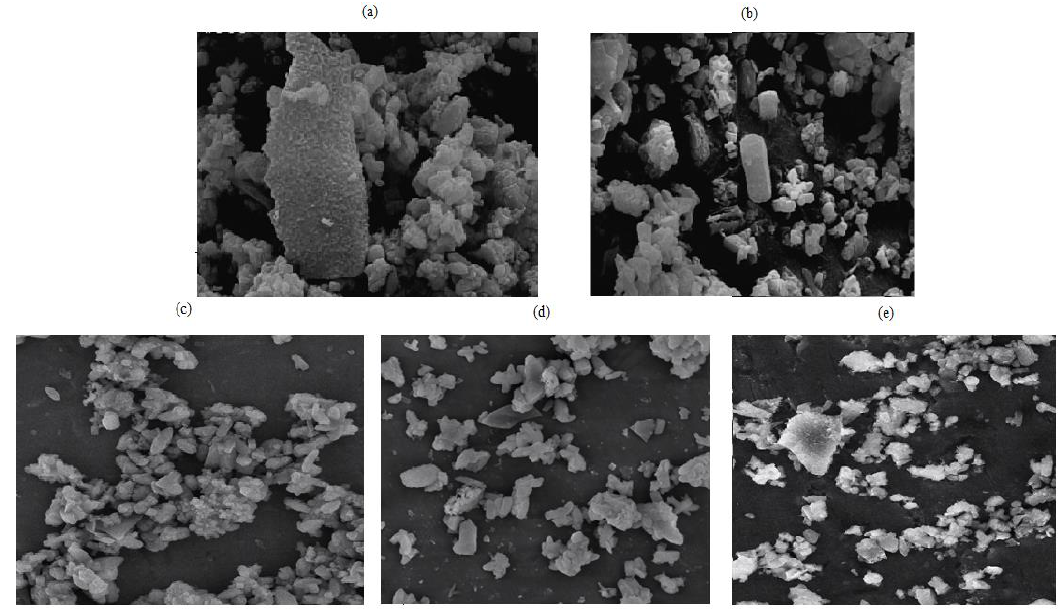
Figure 2. SEM images for ( a ) NaZSM-5; ( b ) HZSM-5; ( c ) 4 wt. % FeHZSM-5; ( d ) 4 wt. % CuHZSM-5; and ( e ) 4 wt. % ZnHZSM-5 catalysts.